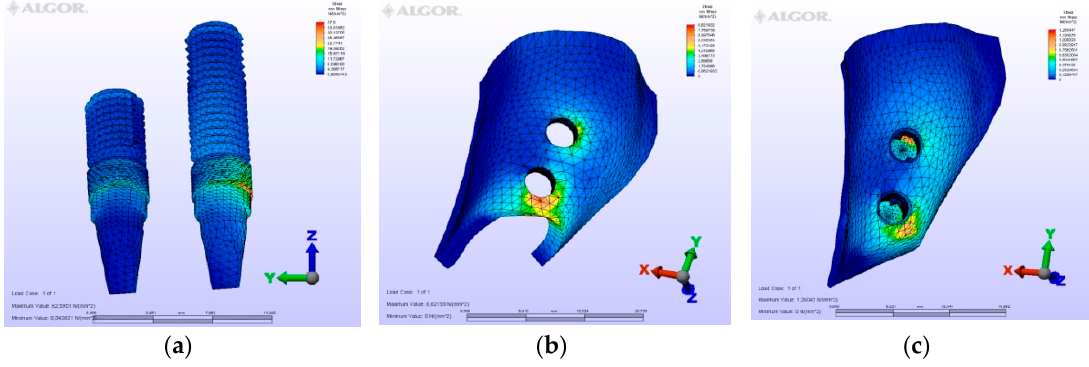
Figure 10. Model M3, horizontal loading. ( a ) the maximum von Mises stresses around implants; ( b ) maximum principle stress in cortical bone; ( c ) maximum principle stress in cancellous bone.